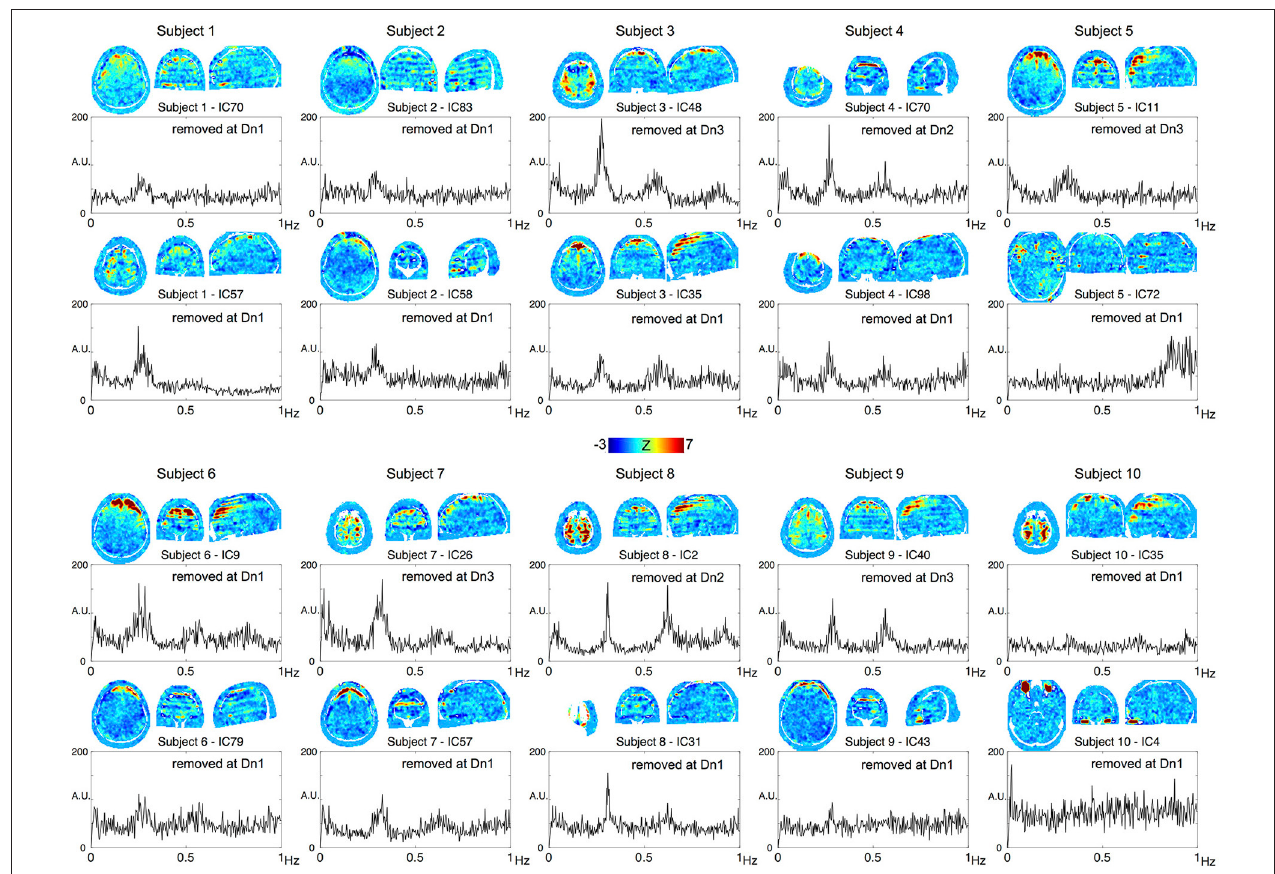
FIGURE 2 | The top two components from each subject, with the highest contribution to the spectral power between 0.2 and 0.3 Hz are shown. All of these components were removed at different denoising levels as indicated in the